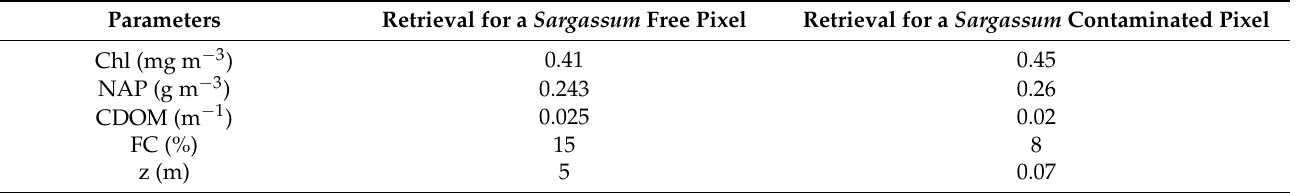
Table 2. Retrieved values of the bio-optical parameters estimated by the SRT inversion method for a Sargassum -free pixel and a Sargassum contaminated pixel for the OLCI data acquired on 8 July 2017. Parameters Retrieval for a Sargassum Free Pixel Retrieval for a Sargassum Contaminated